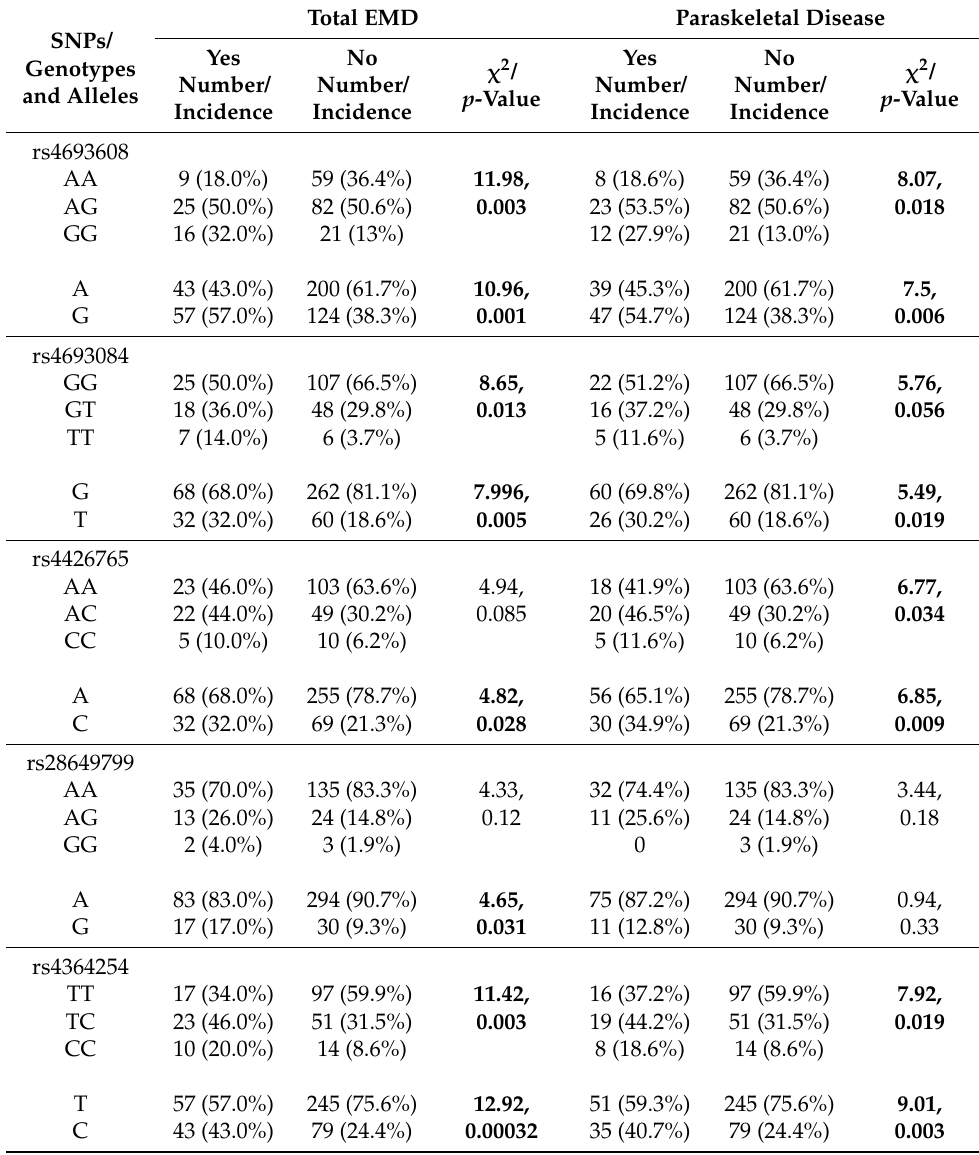
Table 3. Genotype and allele frequencies of the HPSE gene SNPs in correlation with primary extramedullary disease (EMD) in multiple myeloma.